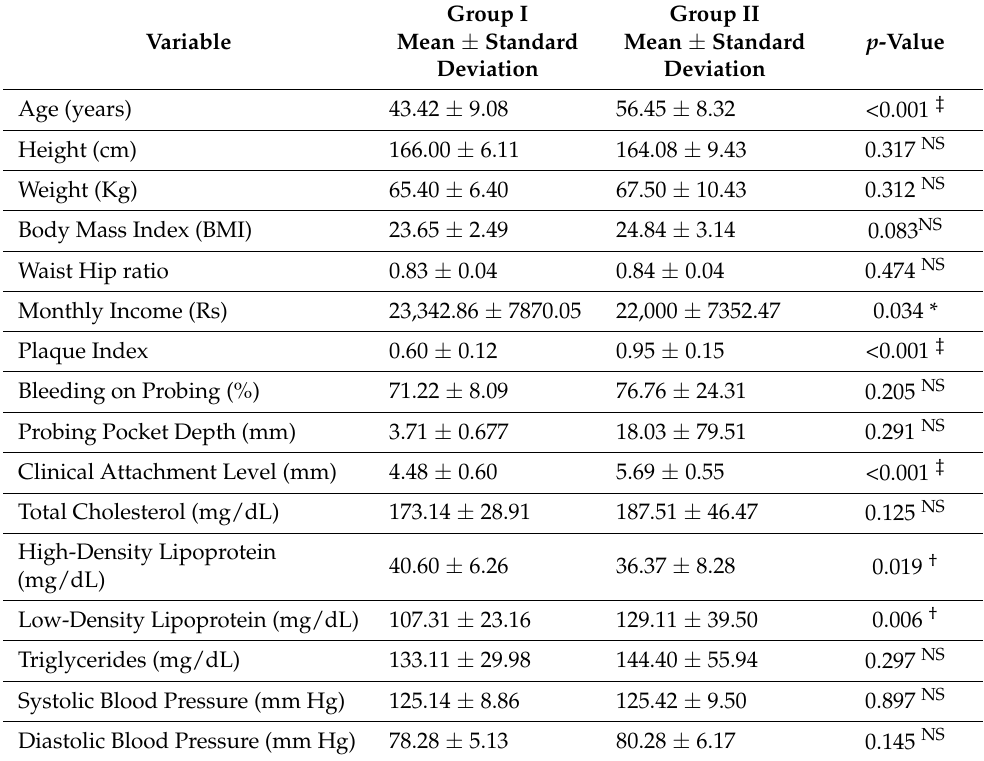
Table 1. Comparison of demographic variables, periodontal parameters, and cardiac parameters between Group I and Group